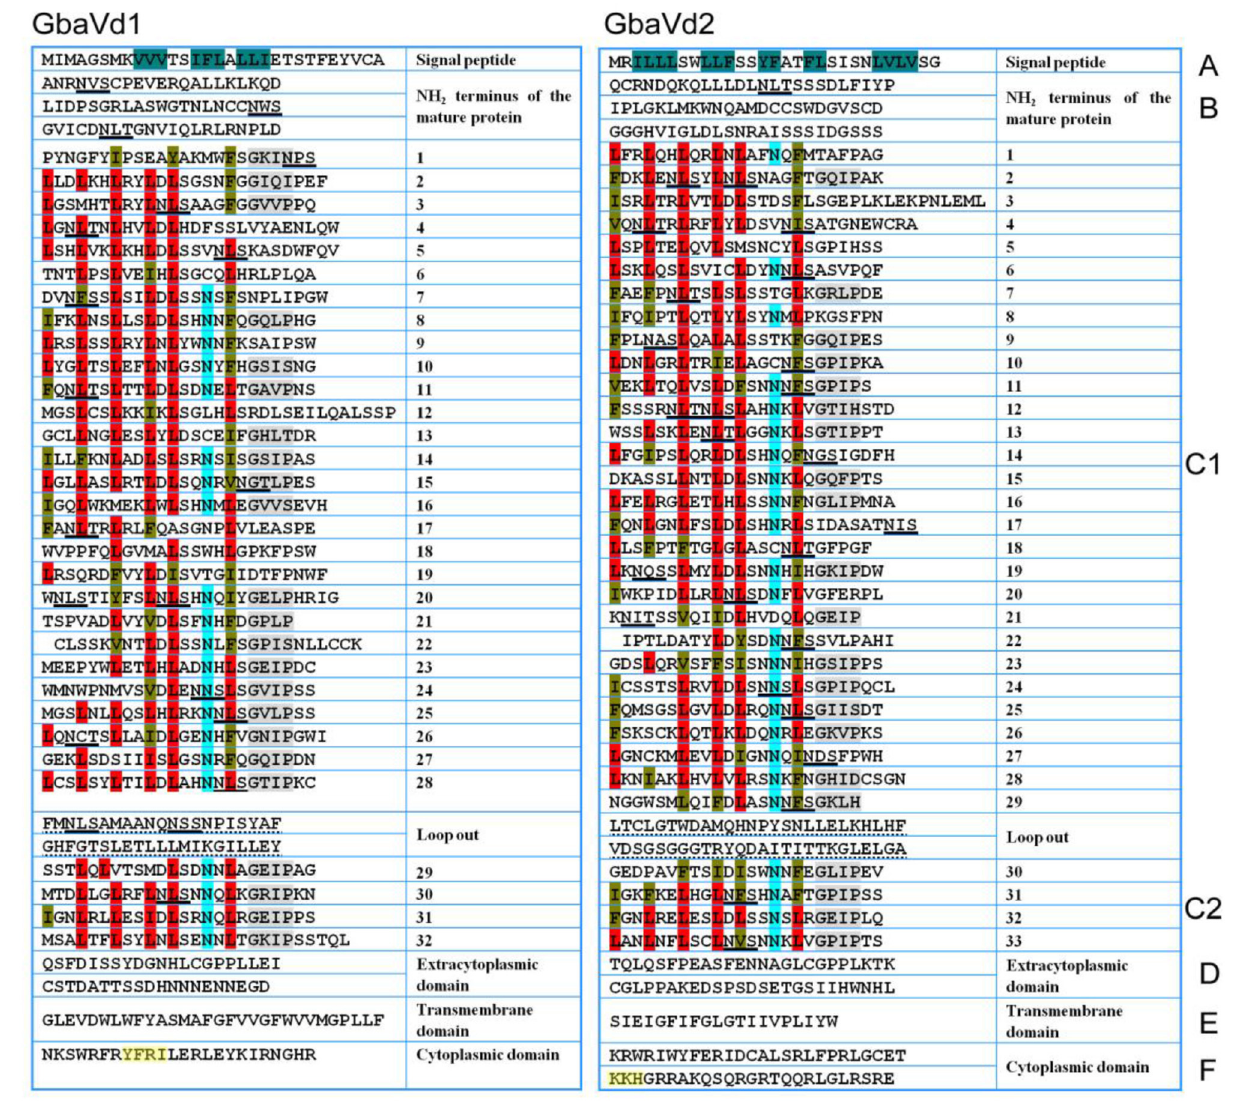
FIGURE 2 | GbaVd1 and GbaVd2 encoded typical RLPs. The primary structures were divided into domains (A–F) . Domain (A) is the putative signal peptide, residues in dark green are hydrophobic amino acids; domain (B) is the putative N-terminus of the mature protein; domain (C) (divided into C1,C2 ) is the LRR domain, in which conserved leucine residues (L, red) are often replaced by isoleucine (I), phenylalanine (F), or valine (V) (brown), conserved N-termini are highlighted in light blue, and the conserved GxIP motif is depicted in gray; domain (D) is a negatively charged extracytoplasmic peptide with neutral and acidic amino acids; domain (E) is the transmembrane-associated domain; domain (F) is the small cytoplasmic peptide with neutral and basic amino acids, with the endocytosis signal motifs highlighted in yellow. Putative N -glycosylation sites Nx(S/T) present in domains (B,C) are underlined with black